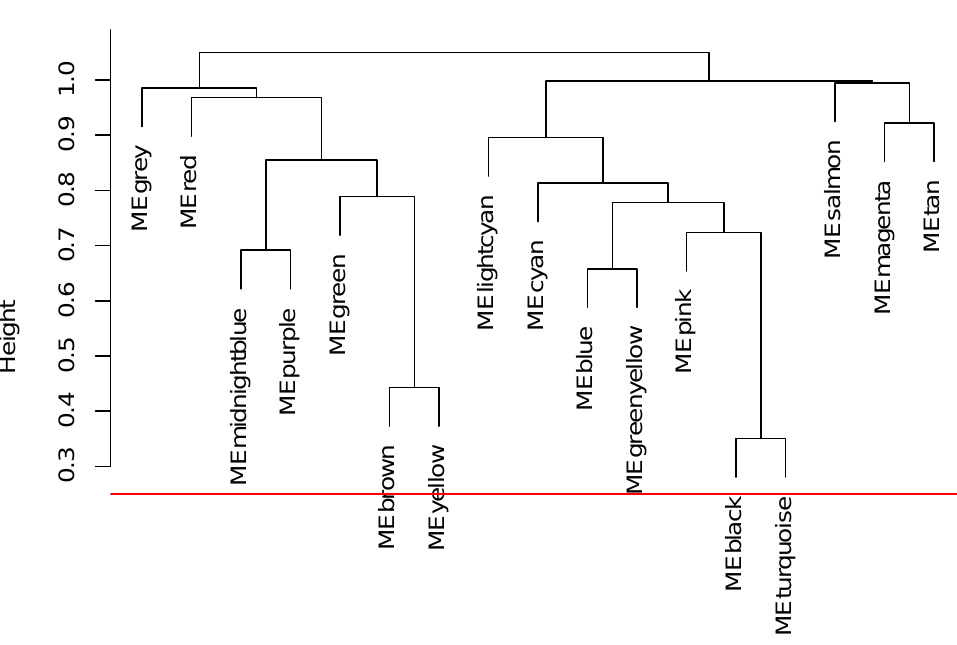
Figure A5. Calculating the module similarity to merge the modules with high